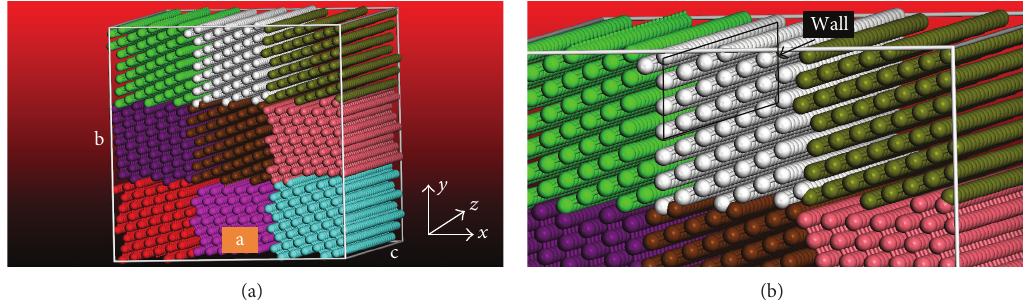
Figure 6: Coarse-grained PPTA fiber computational cell consisting of nine coaxial fibrils (indicated using different colors): (a) zoomed-out view; and (b) a close-up